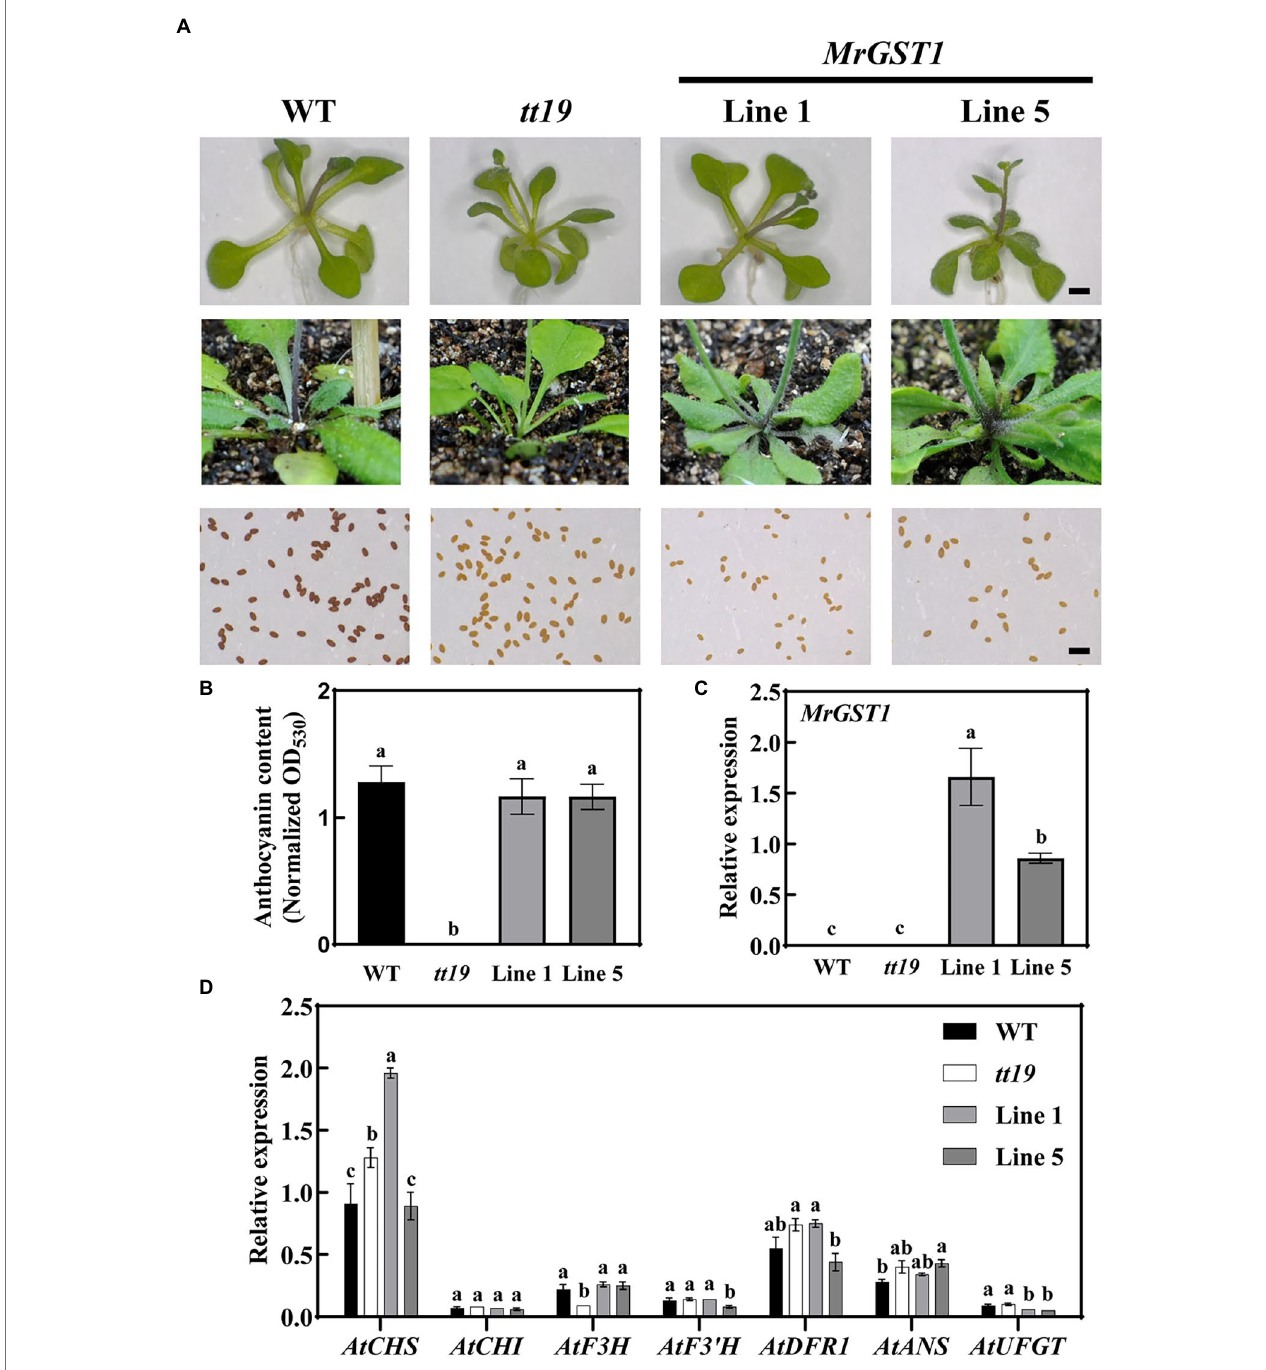
FIGURE 4 | Complementation of tt19 mutant with functional MrGST1 (glutathione S -transferase). (A) Phenotypes of the Arabidopsis wild type (WT), mutant ( tt19 ), and transgenic lines ( 35S::MrGST1 / tt19 , Line 1 and Line 5). Pictures of the seedlings, the base of the rosette and fresh seeds were shown. Black bar: 1 mm. (B) Anthocyanin content. (C, D) Expression of MrGST1 (C) and anthocyanin-related genes (D) of base portion of the rosette and stems. Data were means (±SE) from three independent biological replicates. Same letter indicates no significant difference ( p <